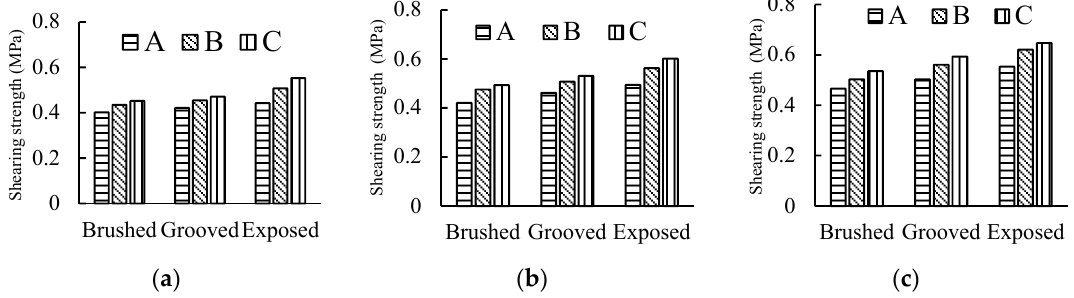
Figure 8. Maximum shear strength of different cement slab surfaces and spreading schemes: ( a ) SBS- modified emulsified asphalt; ( b ) 90 ordinary hot asphalt; ( c ) SBS-modified asphalt.